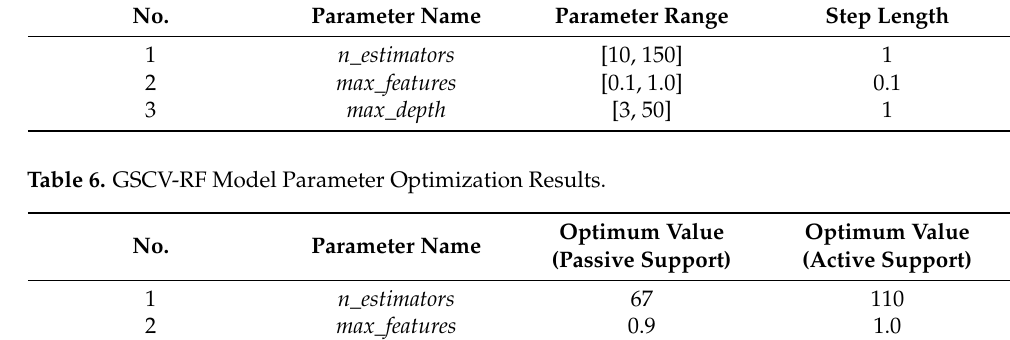
Figure 9. The active support RF model prediction results. ( a ) Correlation evaluation of the measured and predicted values of α; ( b ) curves of the measured and predicted values of the samples; ( c ) sample prediction error curve; ( d ) sample error frequency distribution.